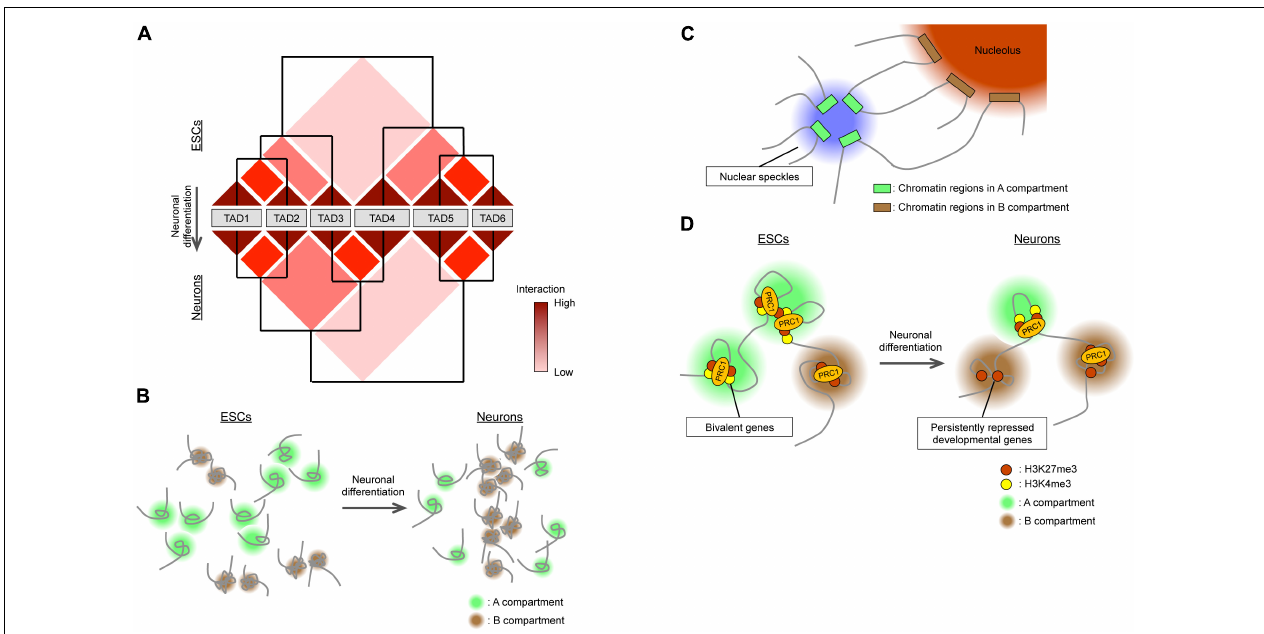
FIGURE 2 | Global changes in 3D genome organization during neural differentiation. (A) TADs are organized in a hierarchical manner, and their reorganization accompanies neural differentiation. (B) During neural differentiation from ESCs, interactions within the A compartment decrease while those within the B compartment increase. The size of the A compartment also decreases during neural differentiation. (C) Nuclear speckles and nucleoli act as hubs for interactions within A and B compartments, respectively. (D) In ESCs, bivalent genes interact with each other via PRC1 in the A compartment. Neural differentiation is accompanied by the loss of PRC1-mediated interactions between bivalent genes, with the genes becoming persistently repressed and relocating to the B